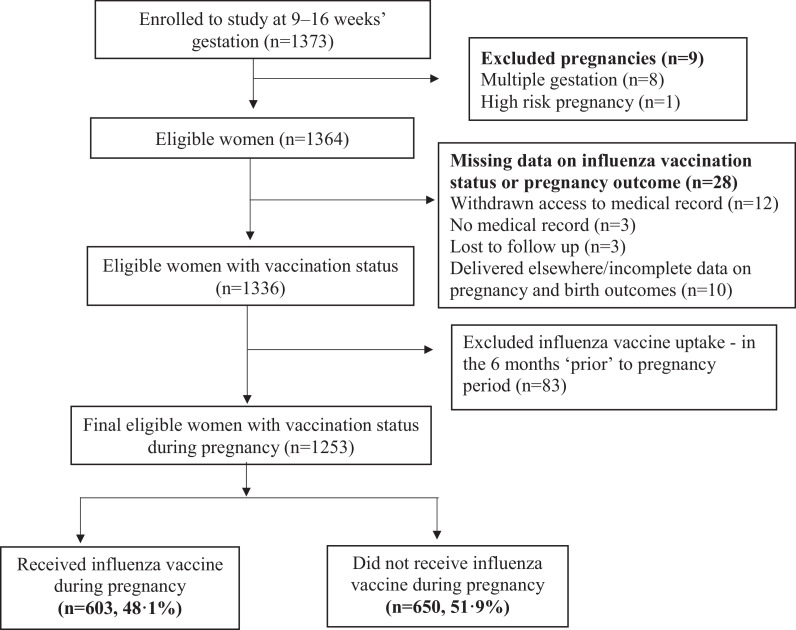
Participants flow diagram.